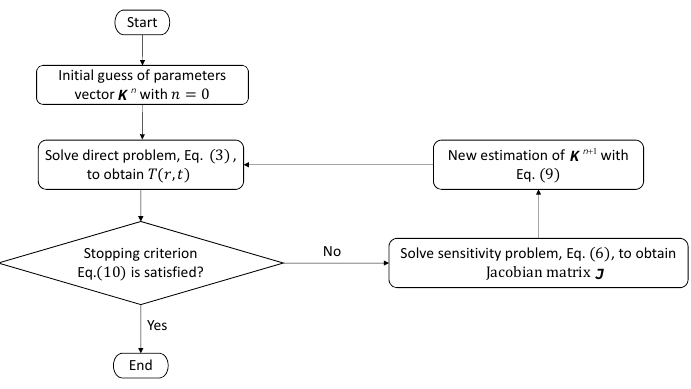
Figure 2. Flow chart of iterative